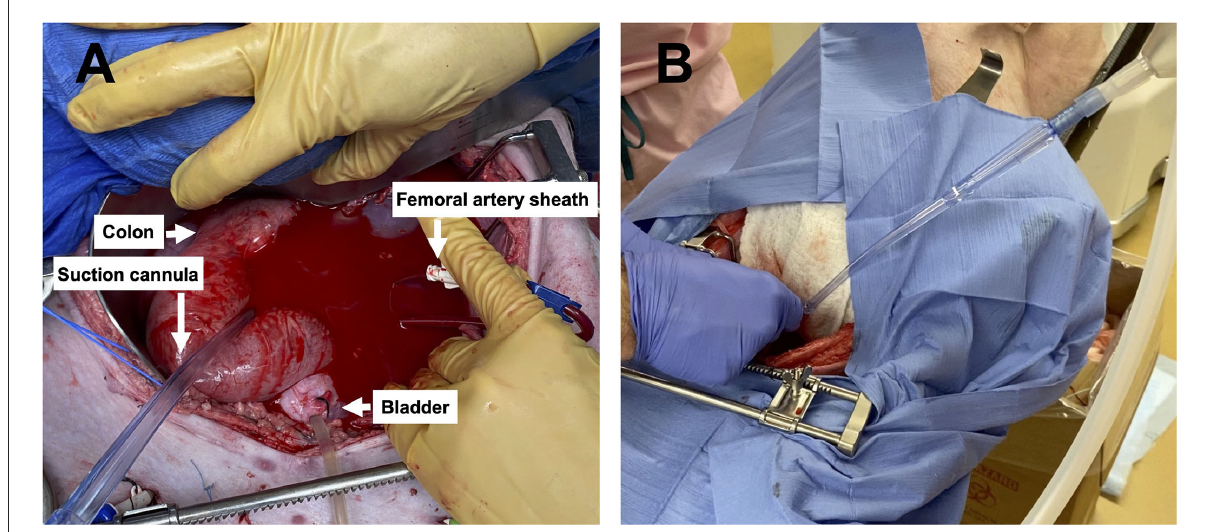
FIGURE3 Images of the pelvic hemorrhage model and device set-up: (A) The pelvic exposure with the femoral artery sheath actively hemorrhaging into the pelvic well and (B) the set-up of the Hemafuse device with the suction cannula in the pelvic well.